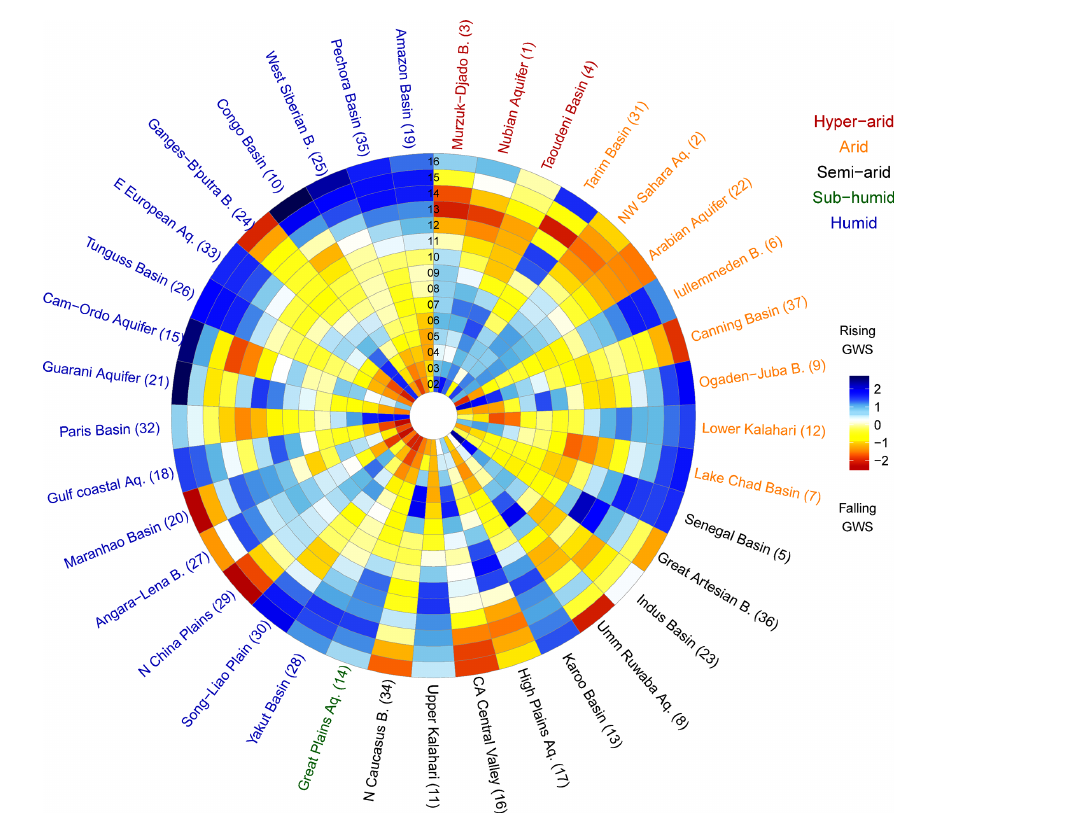
Figure 8. Standardised monthly anomaly of non-linear trends of ensemble mean GRACE (cid:49) GWS for the 37 large aquifer systems from 2002 to 2016. Colours yellow to red indicate progressively declining short-term trends, whereas colours cyan to navy blue indicate rising trends. Aquifers are arranged clockwise according to the mean aridity index starting from the hyper-arid climate on top of the circular diagram to progressively humid. Legend colours indicate the climate of each aquifer based on the mean aridity index; time in years (2002 to 2016) is shown from the centre of the circle outwards to the